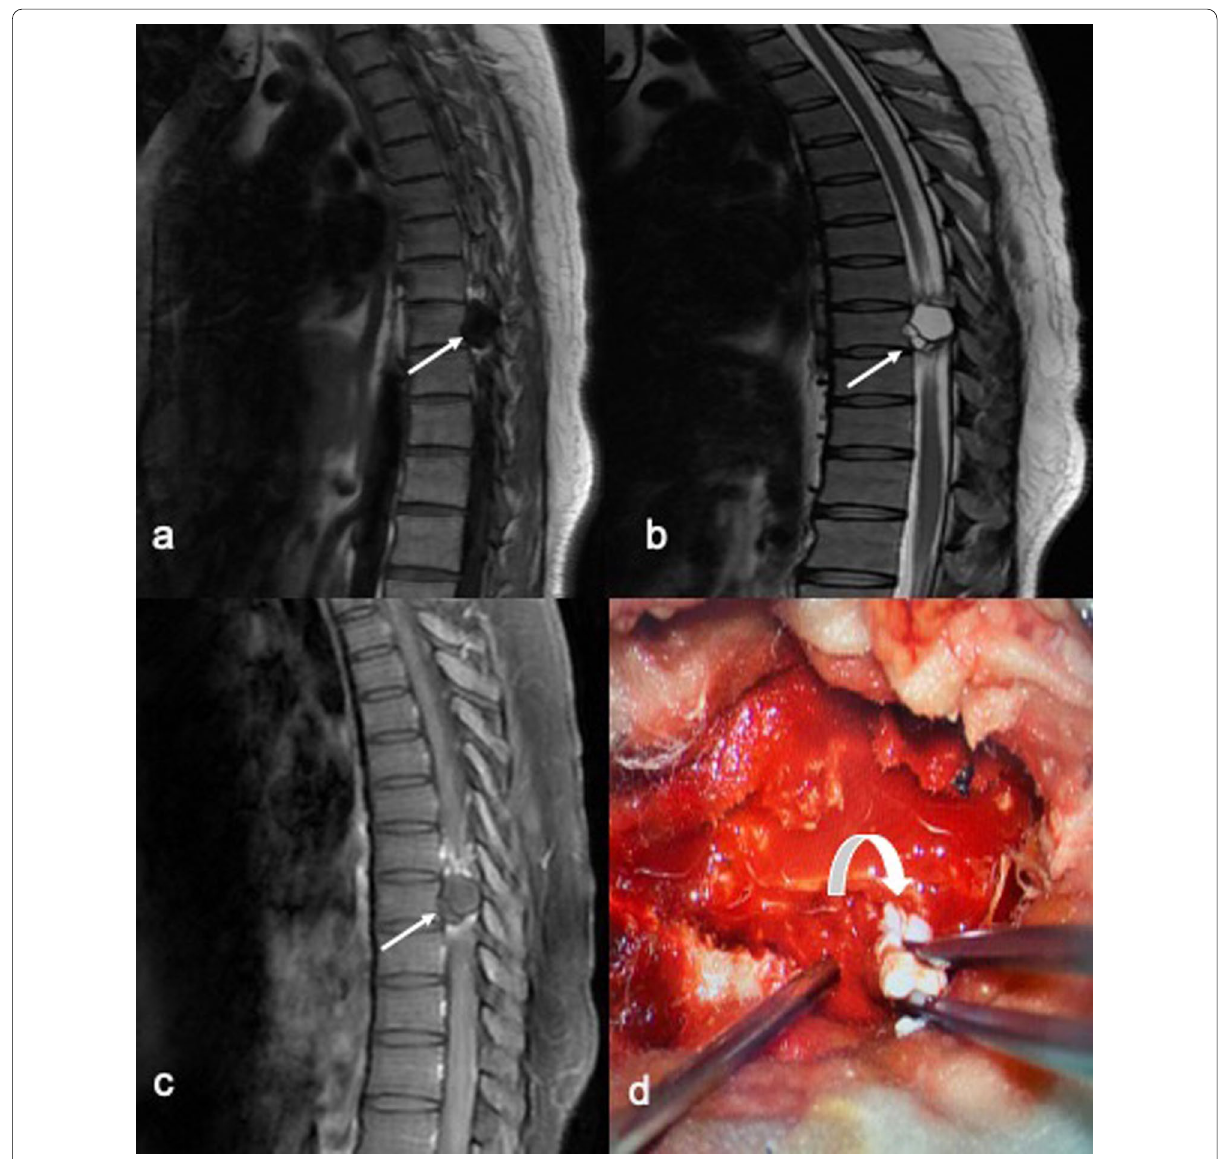
Fig. 1 MRI of dorsal spine in sagittal plane shows a well-defined cystic lesion in the spinal canal [marked with white arrow] a hypointense on T1WI and b hyperintense on T2WI. c Fat-suppressed contrast-enhanced sagittal T1WI shows the absence of enhancement in cyst or its wall. Mild enhancement of adjacent compressed tissue is present. d Per-operative image shows bunch of multiple pearly white cysts (curved white arrow) lying in the extradural